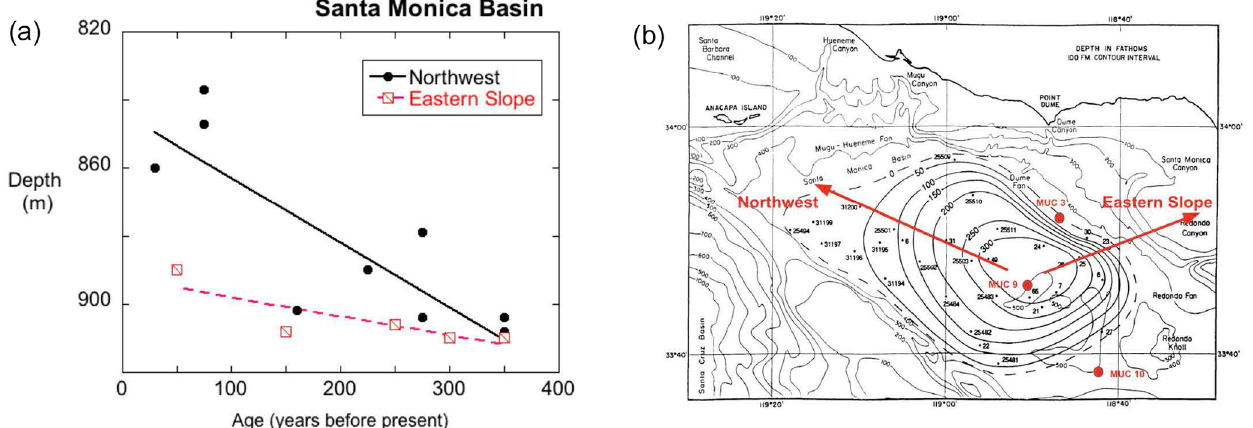
Figure 13. Spreading of the laminated sediment area, defined as a change in depth over time for two transects. Panel (a) shows the spreading rate of laminated sediments as they progress upslope (shallower depths) moving toward the Recent. Panel (b) is modified from Christensen et al. (1994), based on their timescales, and shows the growth in areal extent of laminated sediments since 300 years ago. The location of three MUC cores obtained in 2016 are also shown (red circles). The expansion of laminated sediment accumulation has occurred more rapidly in a northwestern direction than in the eastern